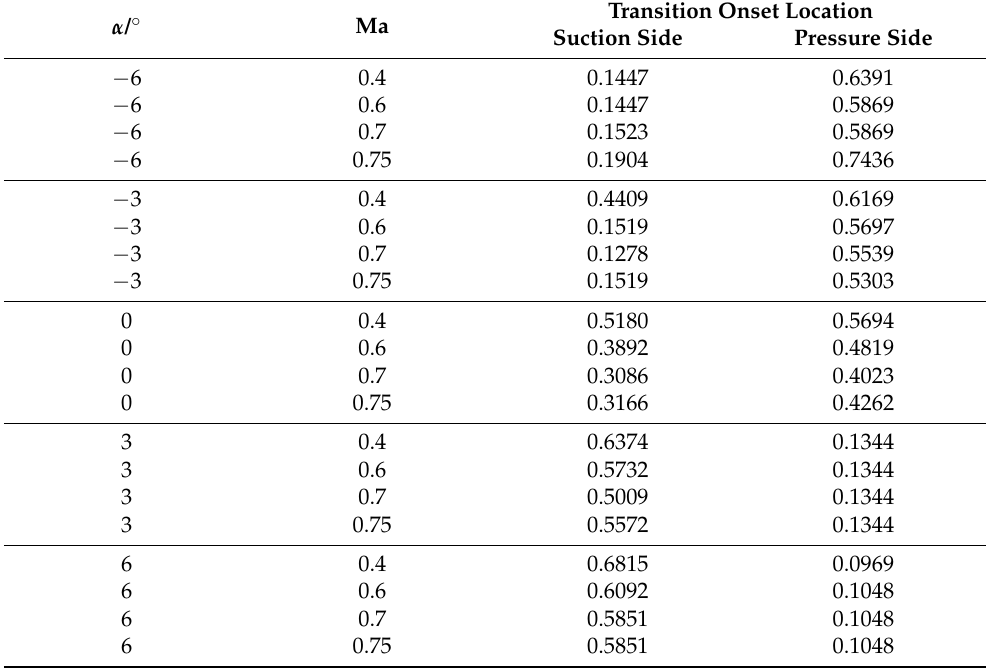
Table A7. Influence of Mach number on transition onset location ( ε = 0.5%, T w = 293